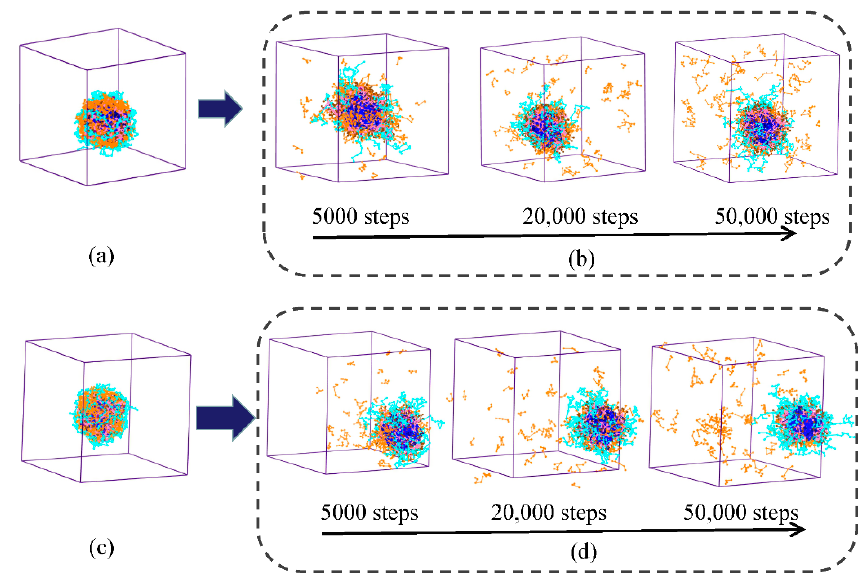
Figure 7. ( a ) DPD equilibrium state of DOX@L-PLGA-D-P under neutral condition. ( b ) DPD morphologies of DOX@L-PLGA-D-P at different simulation time under acidic condition. ( c ) DPD equilibrium state of DOX@S-PLGA-D-P under neutral condition. ( d ) DPD morphologies of DOX@S-PLGA-D-P at different simulation time under acidic condition. The beads of Ad, LA, GA, MAA, DEA (DEAH), TriAZO, mPEG and DOX were represented in red, blue, indigo, pink, brown, purple, light blue and orange,